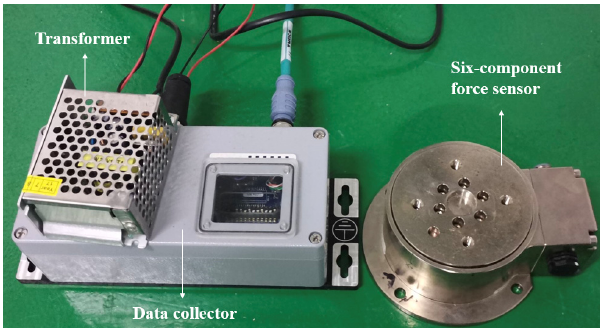
Figure 8. Six-component balance.